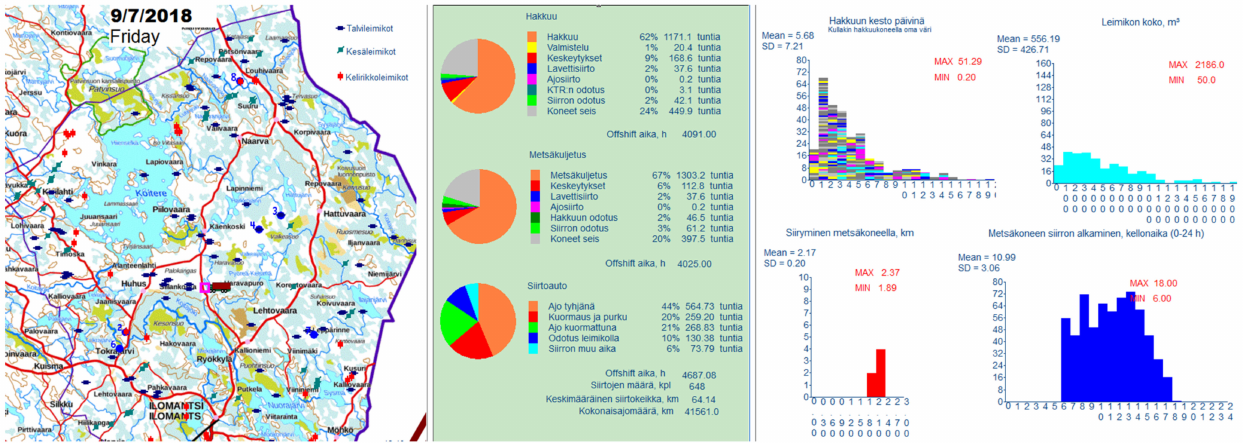
Figure 1. A screenshot of the visualized simulation model for operations of the wood harvesting entrepreneur modeled with Witness simulation software. The left panel of the figure illustrates the operating area with the harvesting sites at the site reserve, location of each numbered HU, and the movement of the relocation truck. The center panel presents the run-time specific work time distributions of machinery, and the right panel shows histograms of the harvesting data of